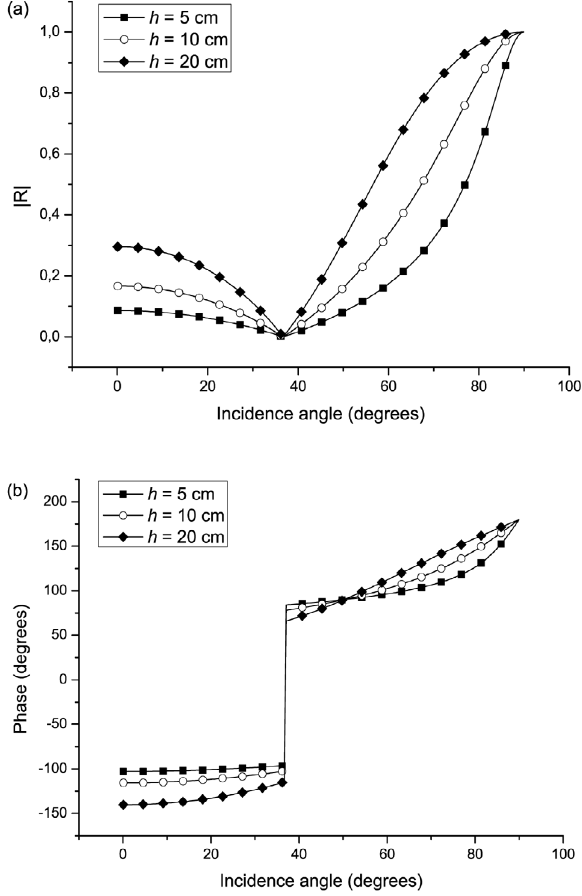
Figure 6. Sandstone layer in mudshale. Absolute value (a) and phase (b) of the P-wave reflection coefficient as a function of the incidence angle and three values of h .